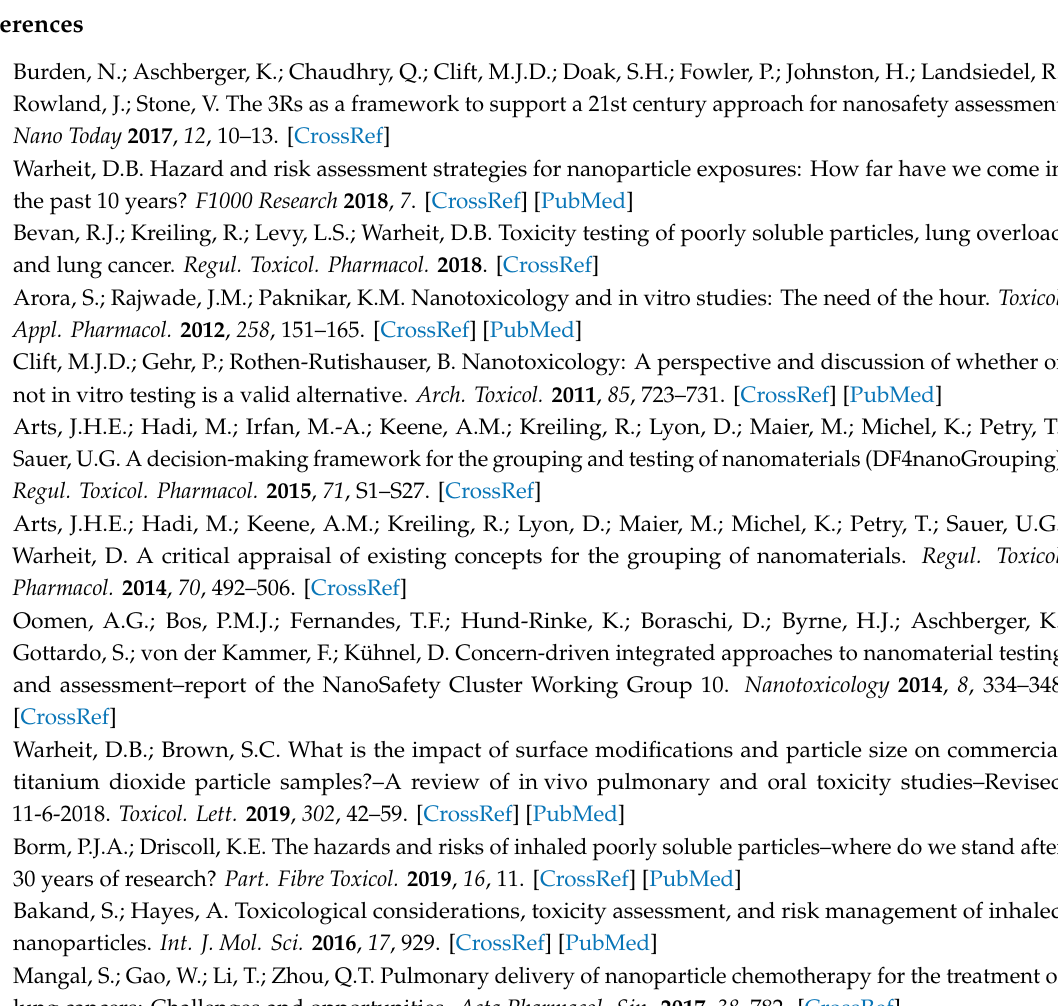
Figure S1: Fluorescence images of A549 cells stained by the LipidTOX dye after a 48-h incubation; Figure S2: Phase contrast images of A549 cells stained by neutral red dye after a 48-h